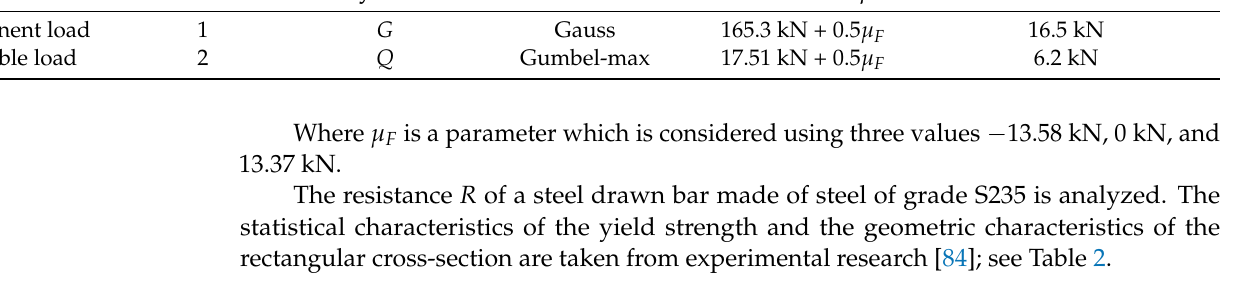
Table 2. The resistance R —input random variables.